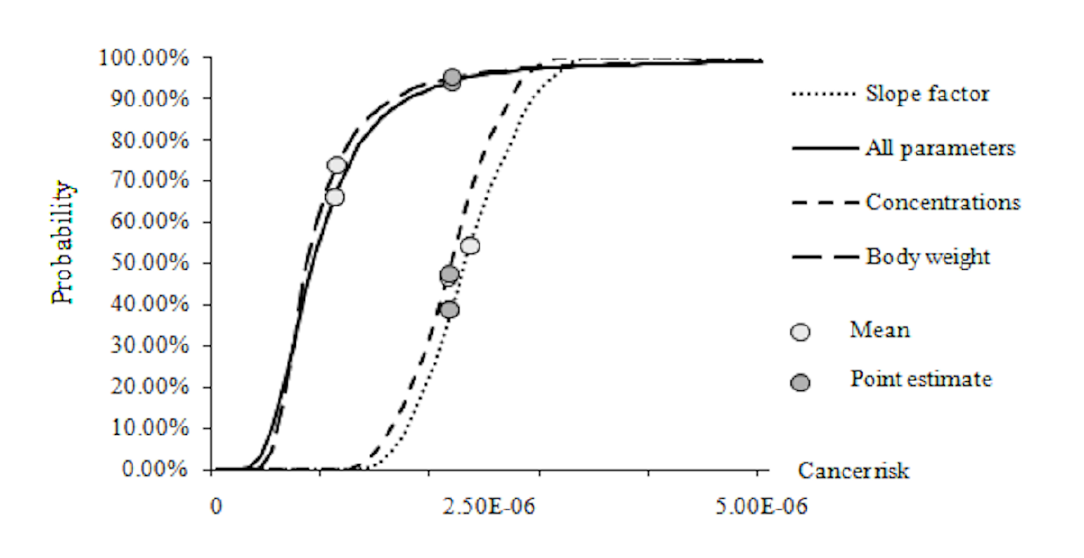
Figure 5. The probability cumulative distribution functions (CDFs) of the cancer risk in